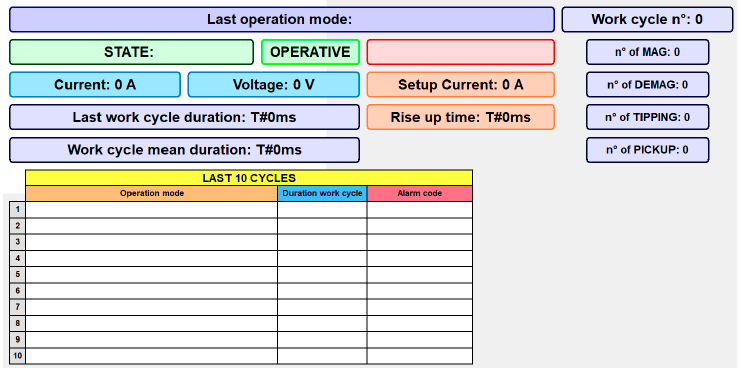
Figure 13. The web interface screenshot.